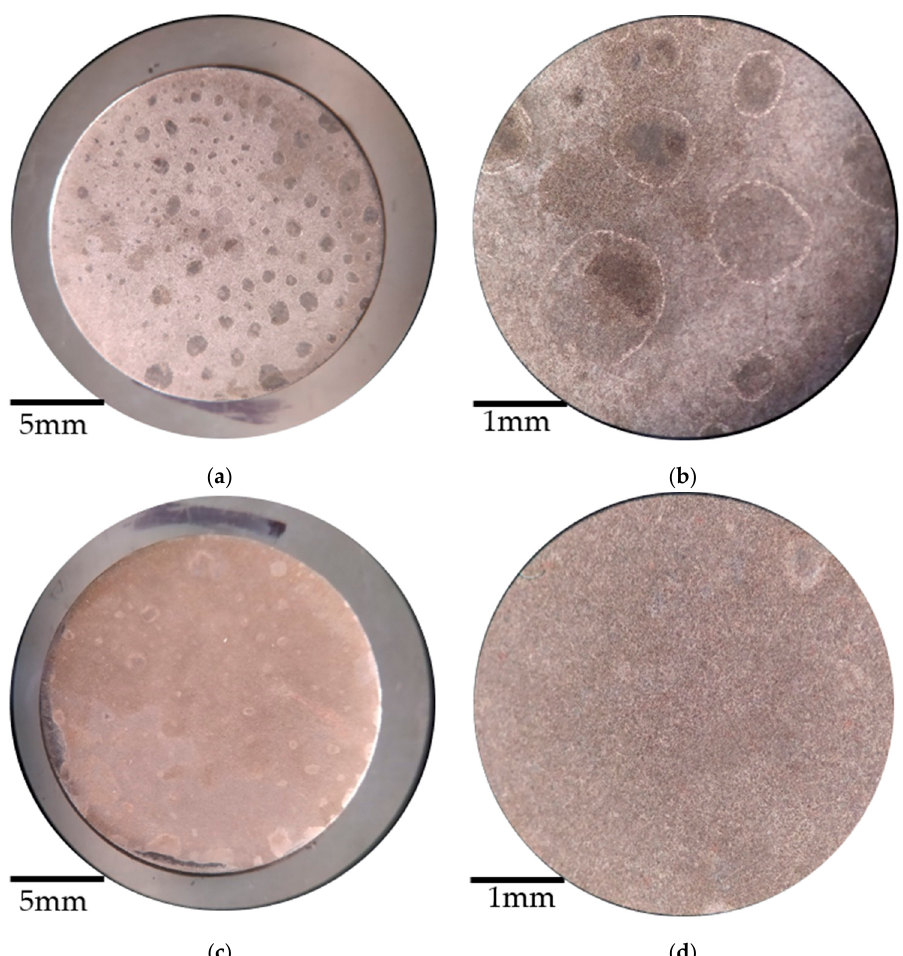
Figure 9. Micrographs after corrosion measurements of structural steel ( a ) polished with magnification 1×, ( b ) polished with magnification 5×, ( c ) coated with magnification 1×, and ( d ) coated with magnification 5×.